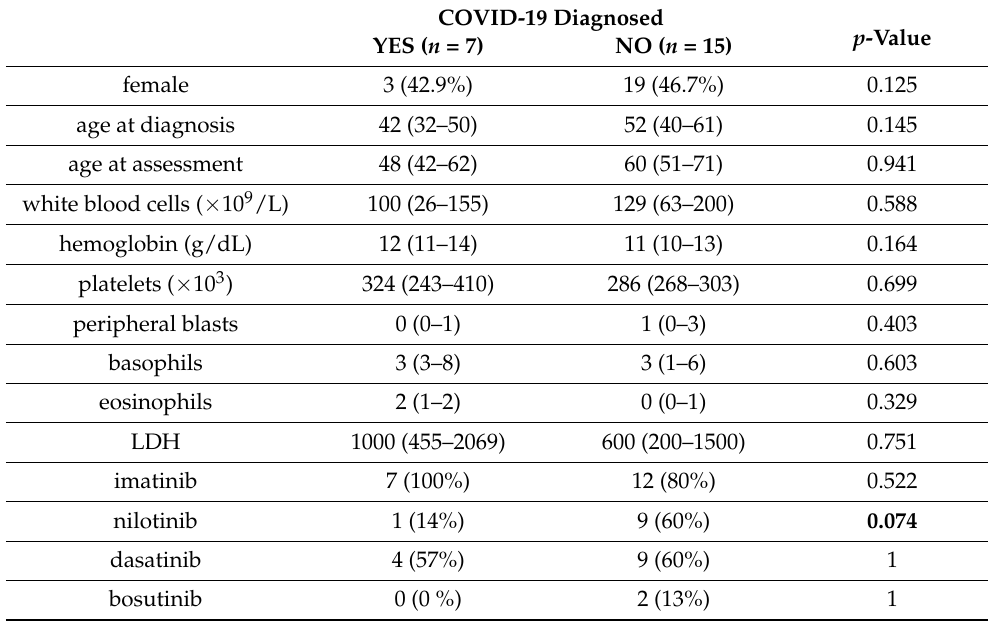
Table 7. Statistical analysis of possible risk variables for adverse effects following COVID-19